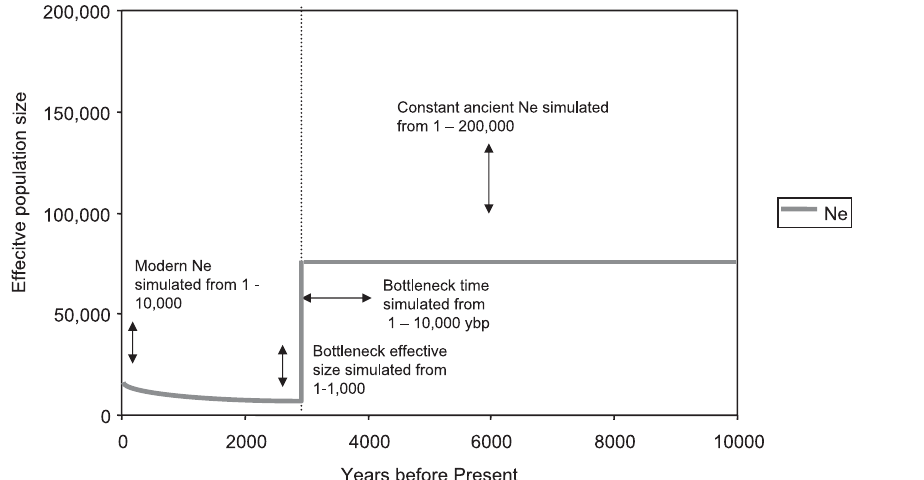
Figure 1. Model of the Population Bottleneck of C. sociabilis Showing a Constant Ancient Female Effective Population Size and Exponential Growth following a Decline in Population Size DOI: 10.1371/journal.pgen.0020059.g001